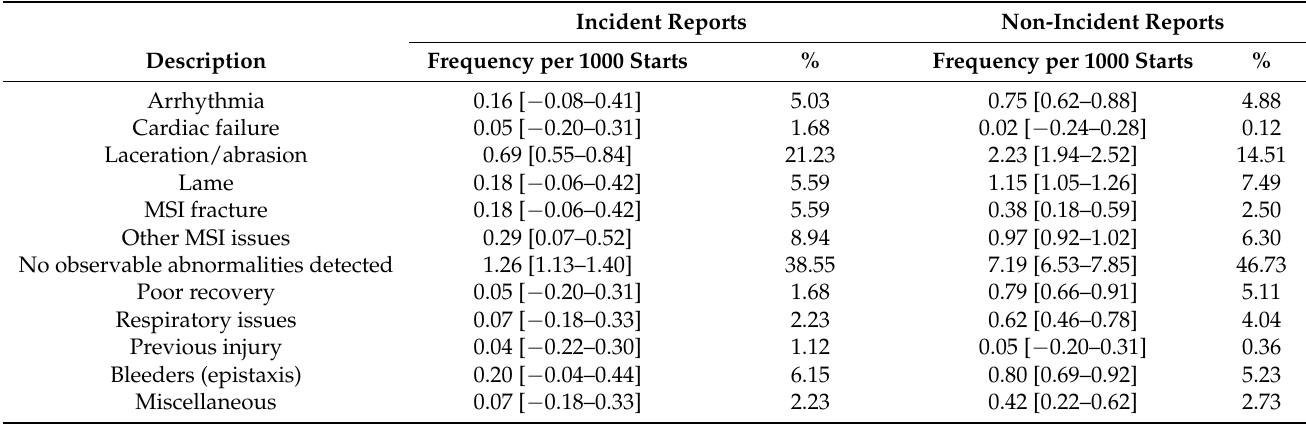
Table 4. Frequency of clinical findings in incident (n = 179) and non-incident (n = 841) stipen- diary reports over two complete Thoroughbred racing seasons. Data are reported as frequency per 1000 starts (with 95% confidence intervals) and the percentage of clinical findings within the respective report type (incident or